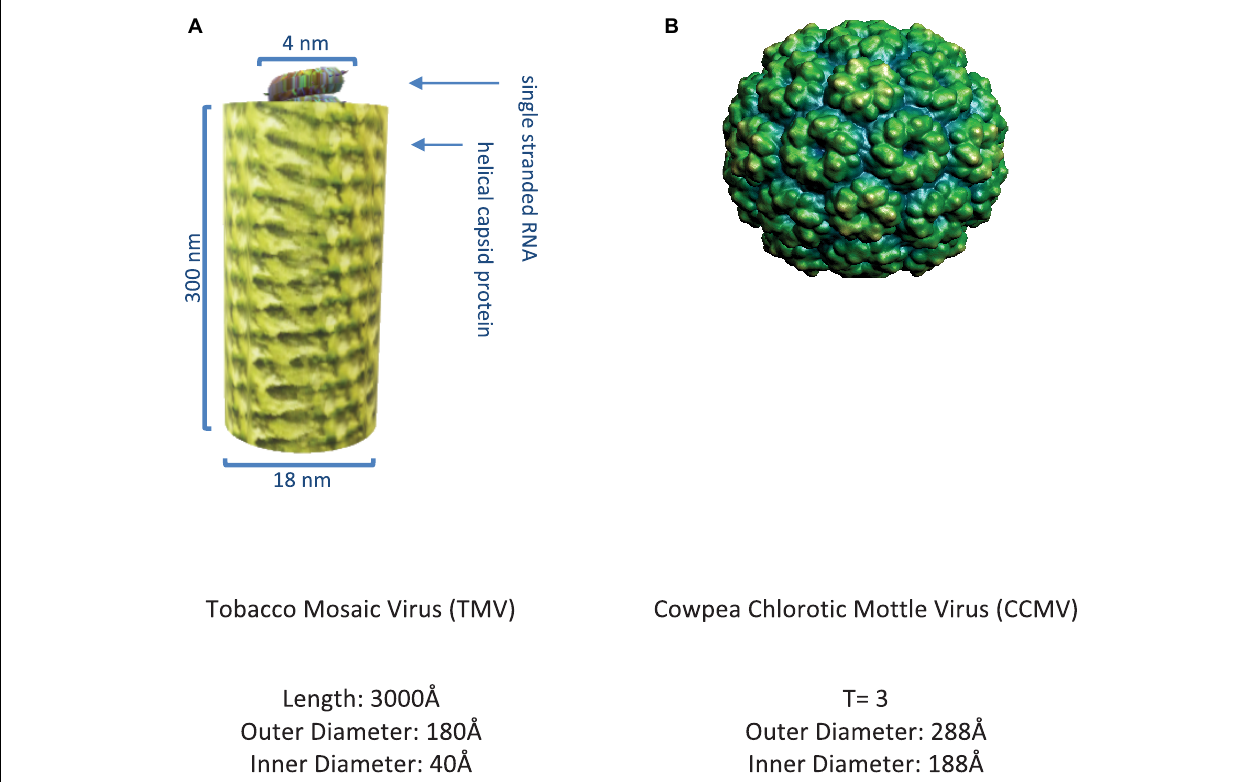
(Zhang and Mason, 2006), or via a Cre- LoxP recombination system (Tremblay et al.,